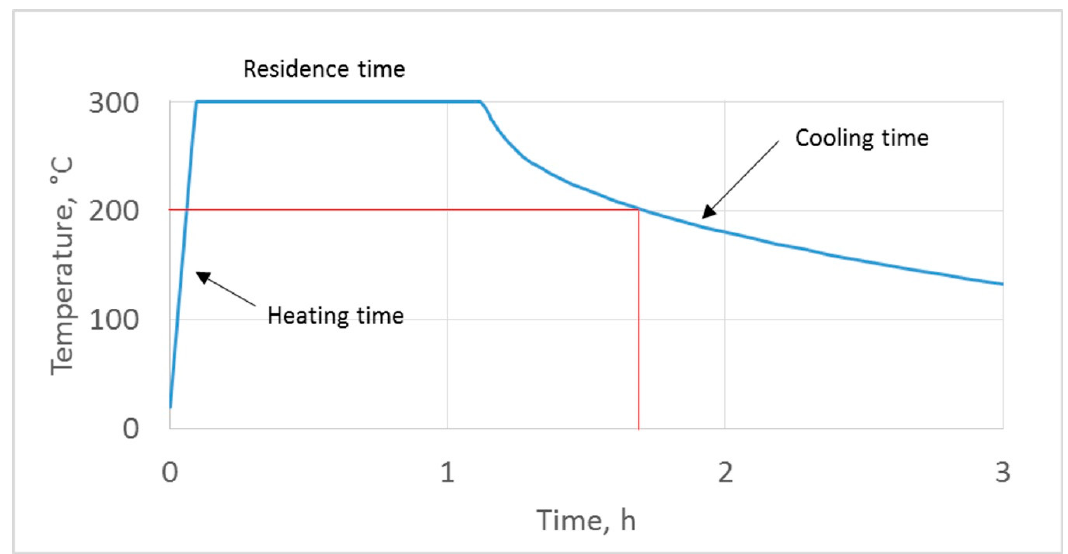
Figure 2. An example of temperature patterns during the torrefaction of sewage sludge and digestate.